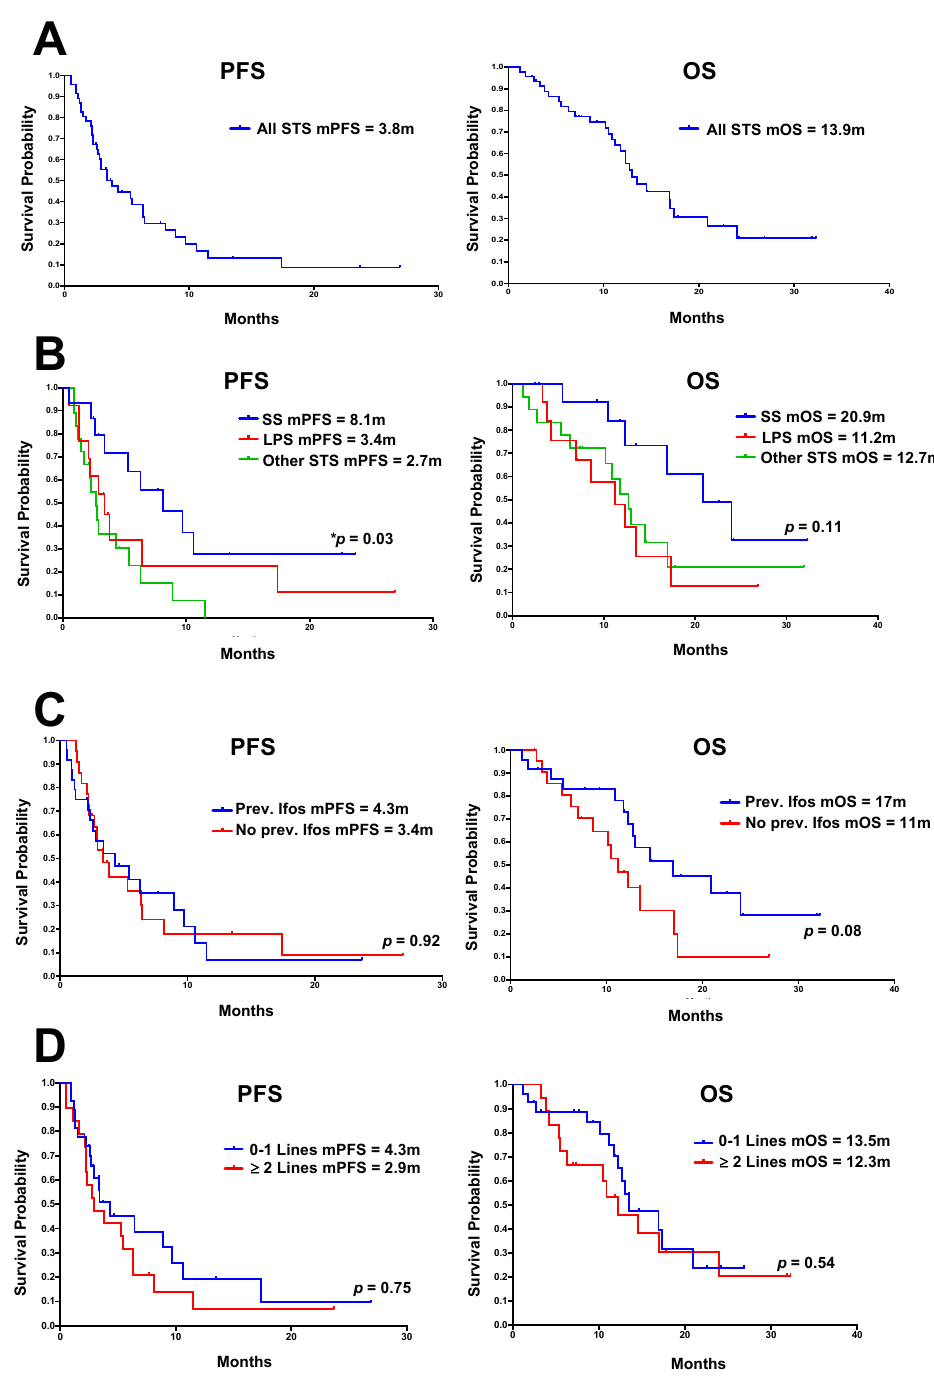
Figure 2. Kaplan–Meier (KM) curves showing PFS and OS in patients with STS. ( A ) All STS patients; ( B ) compared by histological subtype; ( C ) compared by prior ifosfamide exposure; ( D ) compared based on the number of previous chemotherapy lines. Median progression-free survival (mPFS) and overall survival (mOS) for each subgroup are shown. SS = synovial sarcoma, LPS = liposarcoma. Statistical analysis was performed using log-rank (Mantel–Cox) test to compare survival curves. * Statistically significant difference between KM curves.